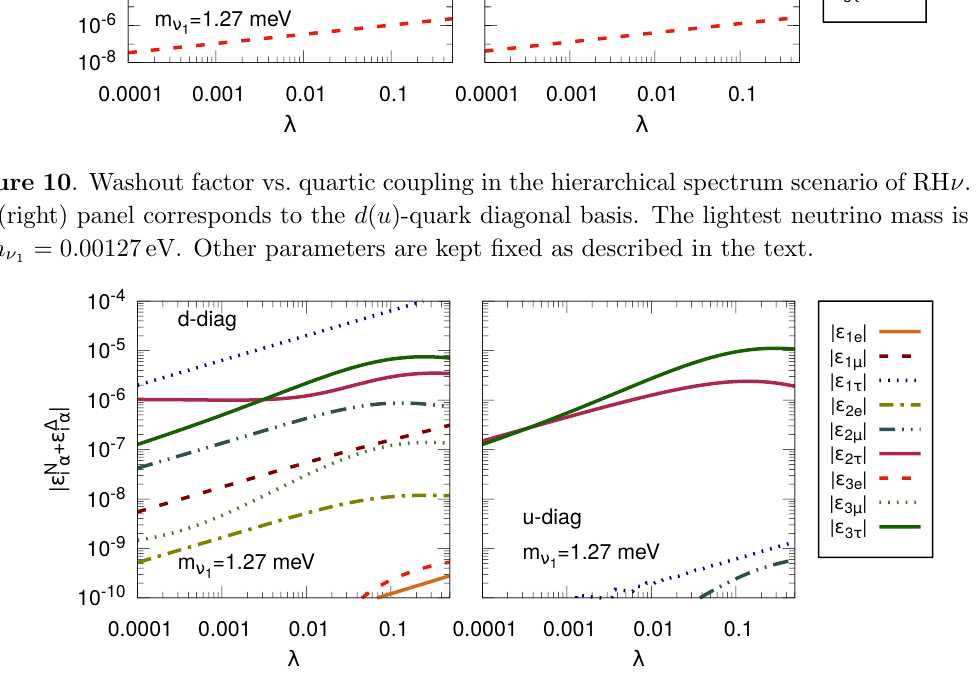
Figure 11 . CP-asymmetry vs. quartic coupling in the hierarchical spectrum scenario of RH (cid:23) . The left (right) panel corresponds to the d ( u )-quark diagonal basis. The lightest neutrino mass is kept at m (cid:23) = 0 : 00127 eV. Other parameters are kept (cid:12)xed as described in the 1